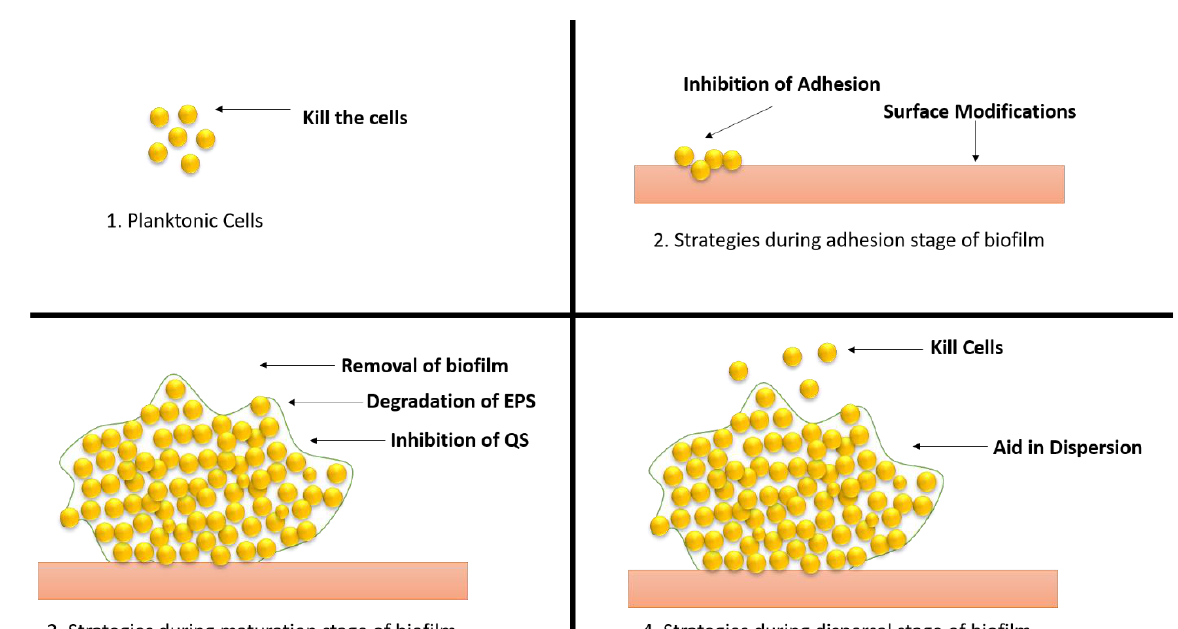
Figure 9. Different strategies of therapeutic approaches to combat the biofilm development. ( 1 ) Strategies applied to planktonic cells; ( 2 ) approaches applied during adhesion stage; ( 3 ) approaches applied during maturation stage; ( 4 ) approaches applied during dispersal stage.